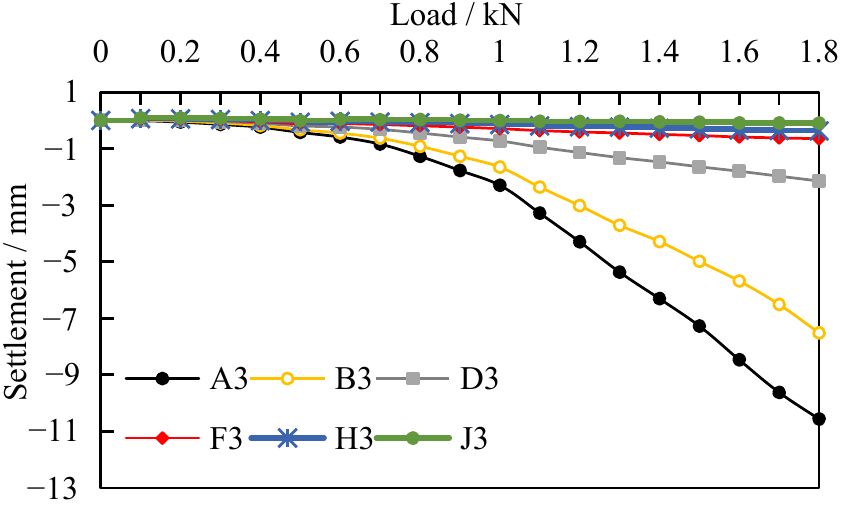
Figure 8. Vertical displacement of each point on Axis 3 (No. 2 pile). As can be seen from Figure 7, the soil in the same buried depth moves horizontally toward the pile body in the initial loading stage, which is likely due to the soil mass below the expanded body being compressed under the load in the initial loading stage. In the middle and late loading periods, the soil near the expanded body generates a horizontal displacement away from the pile body under the load (such as B3, D3, and F3). With the increased load, the horizontal displacement gradually increases, while the horizontal displacement at all points far away from the expanded body (H3 and J3) shows little change. As seen in Figure 8, with the increasing load, the downward displacement of the soil tends to increase as a whole. The farther the soil is from the expanded body, the smaller the vertical displacement. When the load reaches 1.3 kN, the vertical displacement of the soil in A3, B3, D3 and F3 (the four points are, respectively, under the expanded body next to the pile body, below the expanded body, outside the diameter expanded body and far away from the pile) have large differences, which are − 5.4, − 3.7, − 1.1 and − 0.45 mm, respectively. This indicates that the influence range of the soil surrounding the pile is mainly below the expanded body.